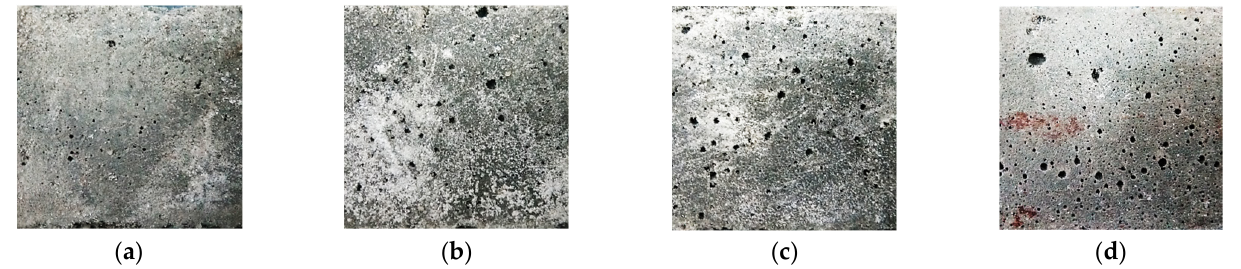
Figure 6. Surficial characteristics of CS − FA − GEO samples: ( a ) FC0T25, ( b ) FC8.8T25, ( c ) FC20T25, and ( d ) FC20T80.